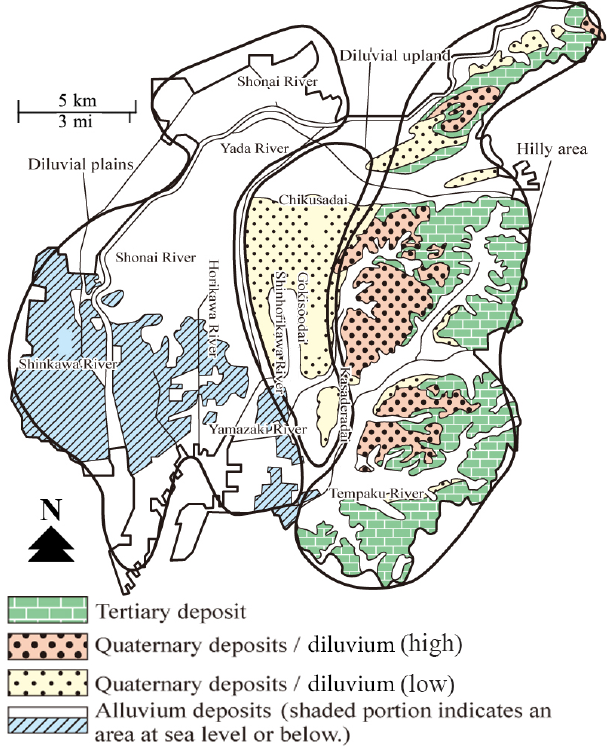
Figure 1. The geological features of Nagoya. (Introduction of Out- line Section of Planning for Nagoya, 2012. Accessed from the official website of Nagoya: http://www.city.nagoya.jp/jutakutoshi/ page/0000045893.html, last access: April